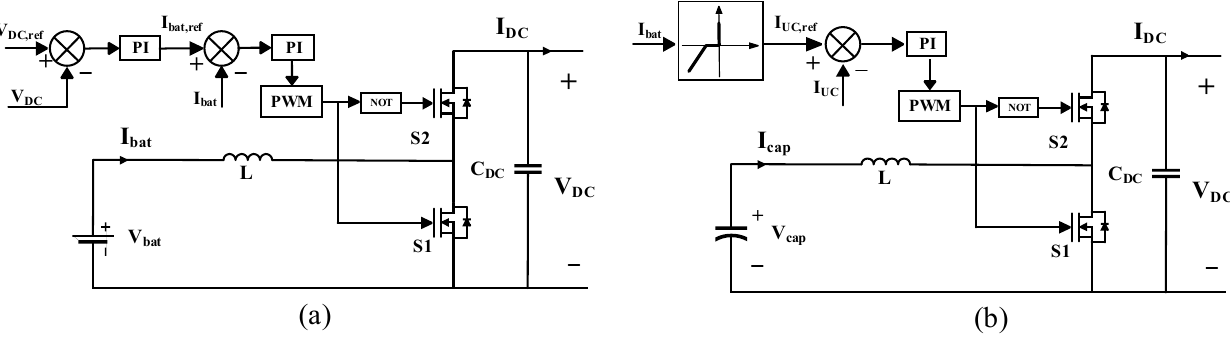
Figure 9. HESS control strategy. ( a ) BES Charging/Discharging; ( b ) UCES Charging/Discharging.